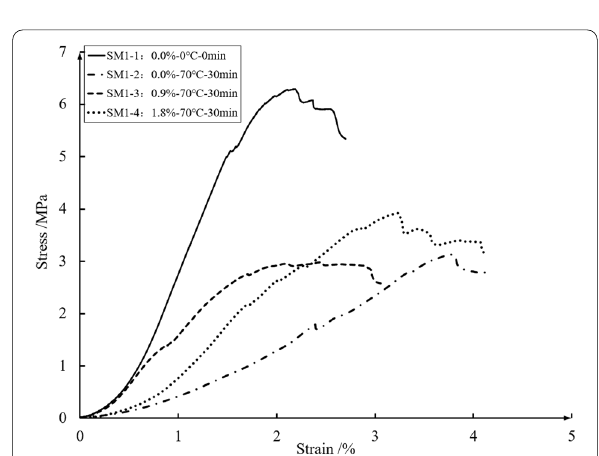
Fig. 13 PCL‑cement paste stress–strain relationship curves with various PCL content.